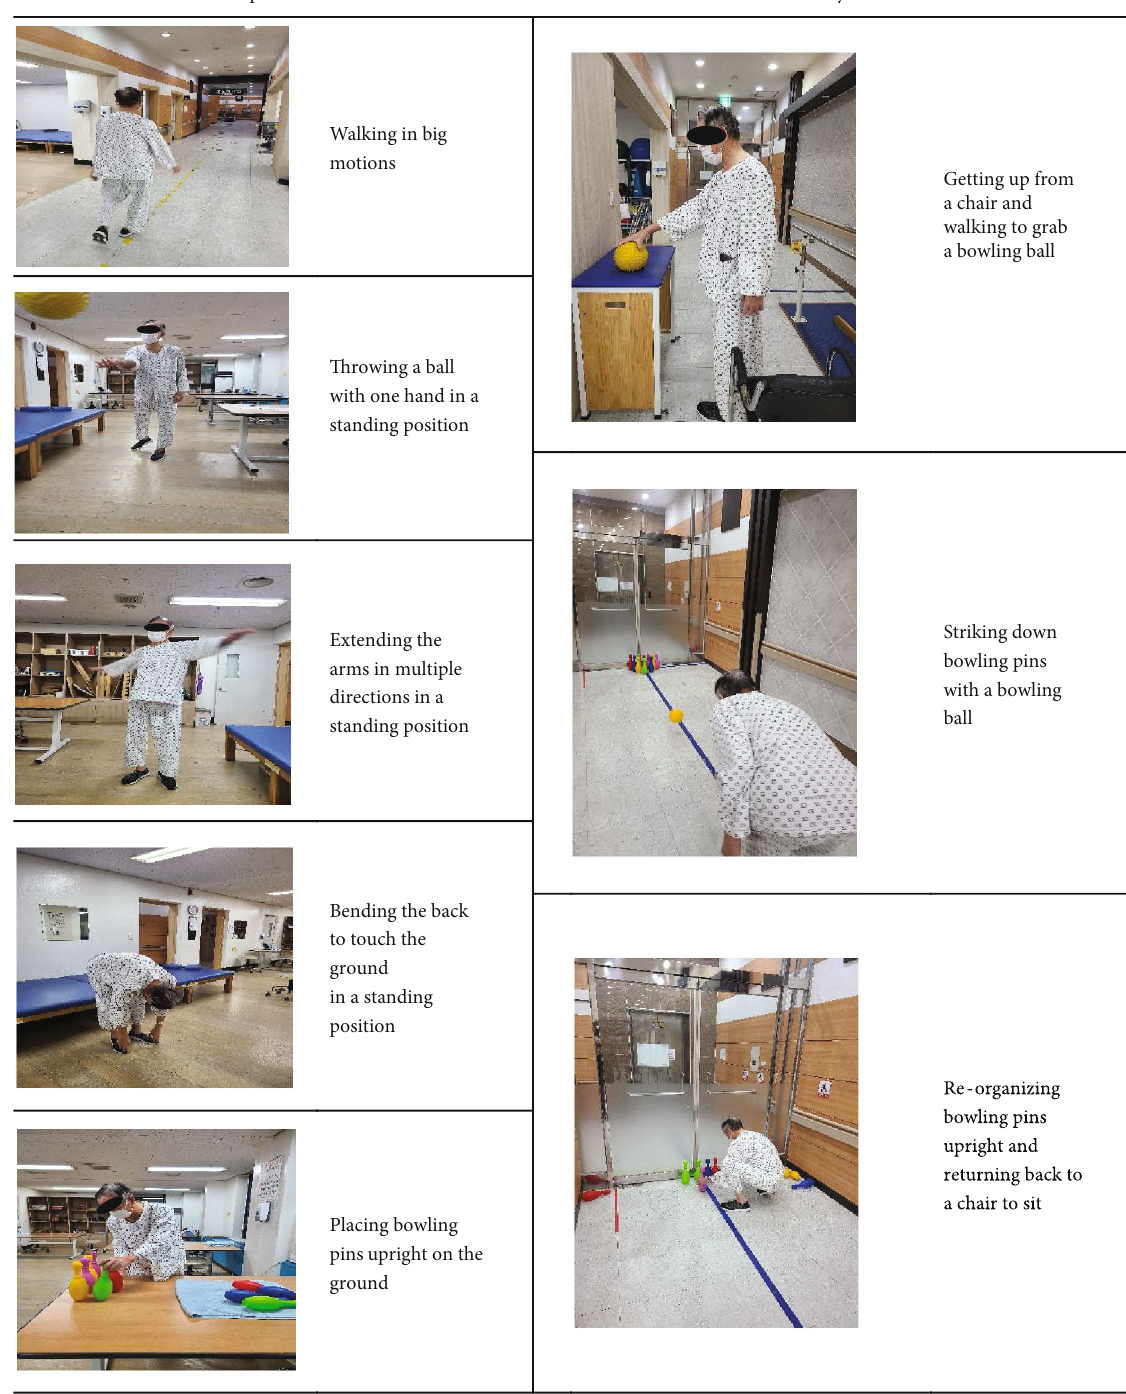
Figure 2: Functional component tasks and hierarchy tasks re fl ecting the tasks performed by participants with images (example of participant decreased signi fi cantly from 57 : 42 ± 10 : 37 to 49 : 71 ± 10 : 33 points ( p < : 05 ). In the control group, state anxiety score decreased signi fi cantly from 51 : 14 ± 10 : 23 to 45 : 85 ± 9 : 02 points ( p < : 05 ), and the trait anxiety score decreased signi fi -